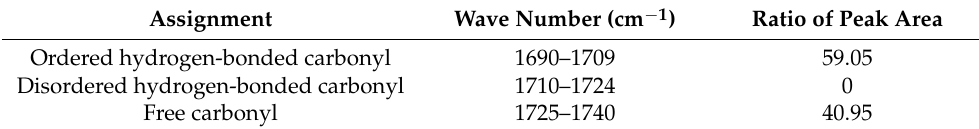
Table 3. Assignment of absorption bonds in carbonyl region of FTIR spectra for PUME.